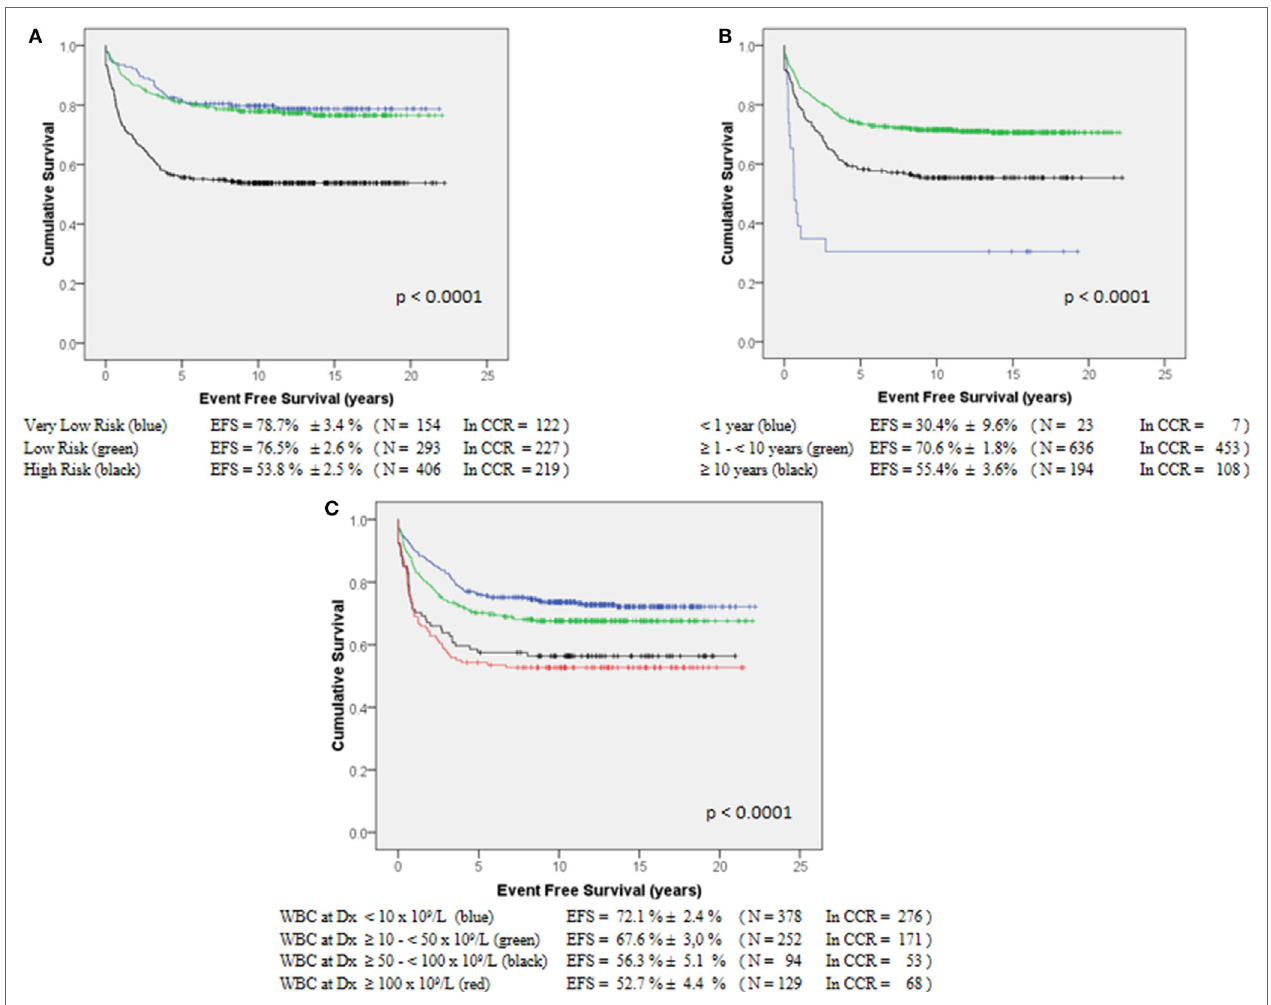
FigUre 2 | event-free survival of 853 all-children treated by gBTli all-93 protocol: (a) according to the protocol risk factors, (B) according to age at diagnosis, (c) according to WBc count at diagnosis